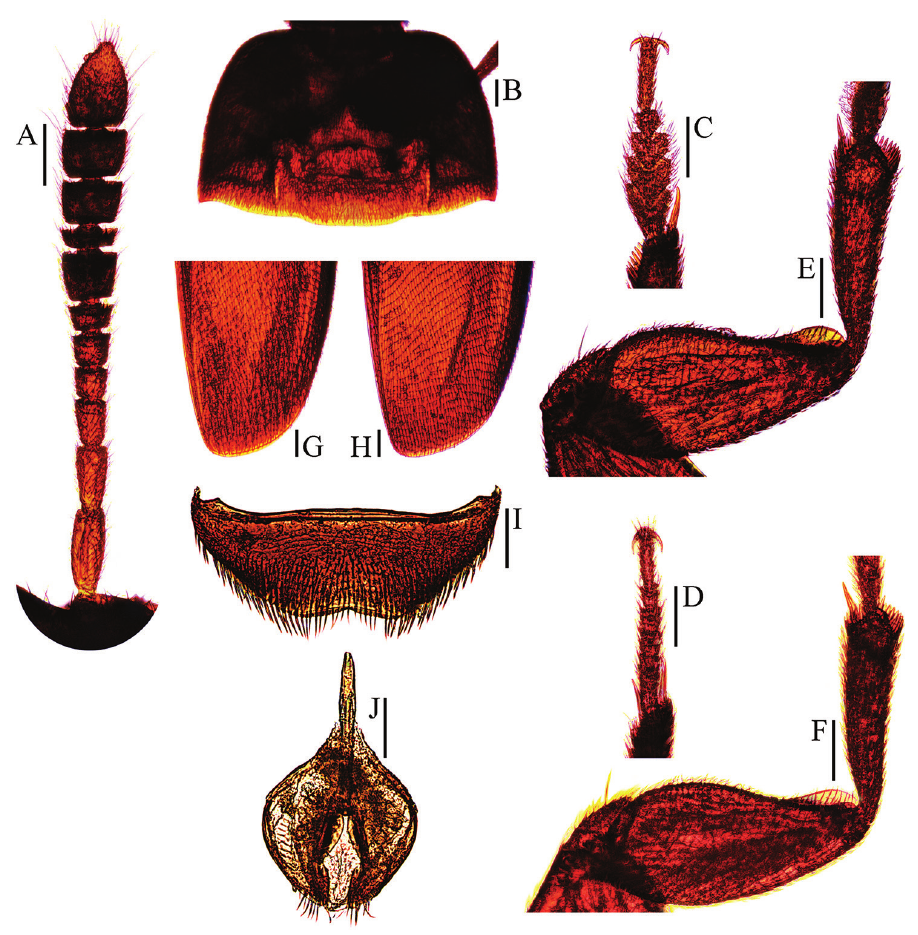
Figure 2. Ptomaphagus (s. str.) nepalensis Perreau, 1988 ( ♂ : paratype; ♀ : paratype). A antenna ♂ (dorsal view) B pronotum ♂ (dorsal view) C protarsus ♂ (dorsal view) D protarsus ♀ (dorsal view) E protibia and profemur ♂ (ventral view) F protibia and profemur ♀ (ventral view) G elytral apex ♂ (dorsoapical view) H elytral apex ♀ (dorsoapical view) I ventrite VIII ♂ (ventral view) J genital segment ♂ (ventral view). Scale bars: 0.1